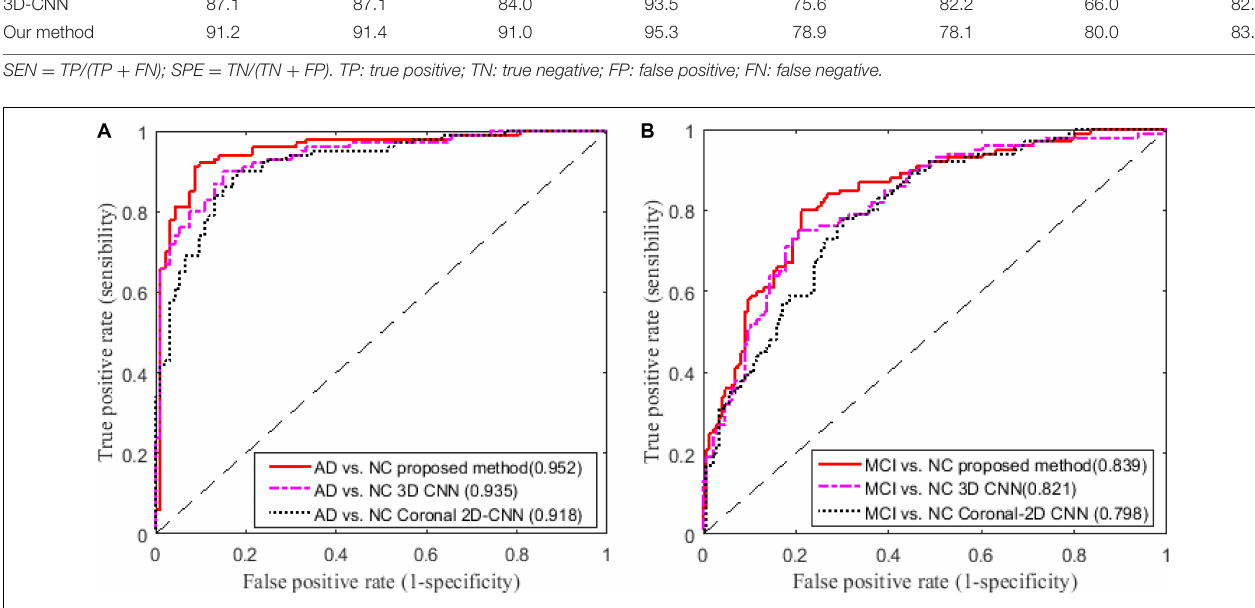
FIGURE 4 | Comparisons of ROC curves on classification of (A) AD vs. NC and (B) MCI vs. NC (AUC is given in brackets).